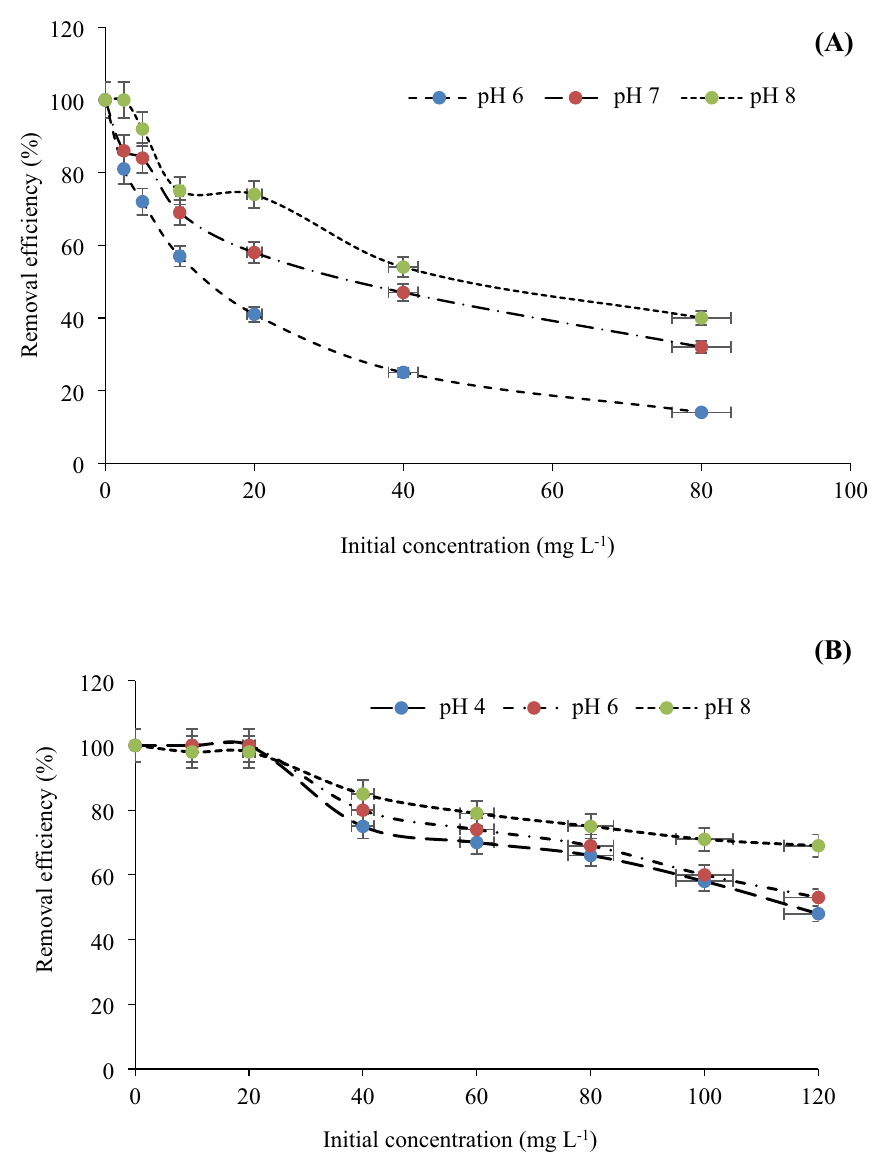
Figure 7. Effect of initial concentration and pH on Cu(II) removal efficiency by (A) Al 2 O 3 , and (B) TiO 2